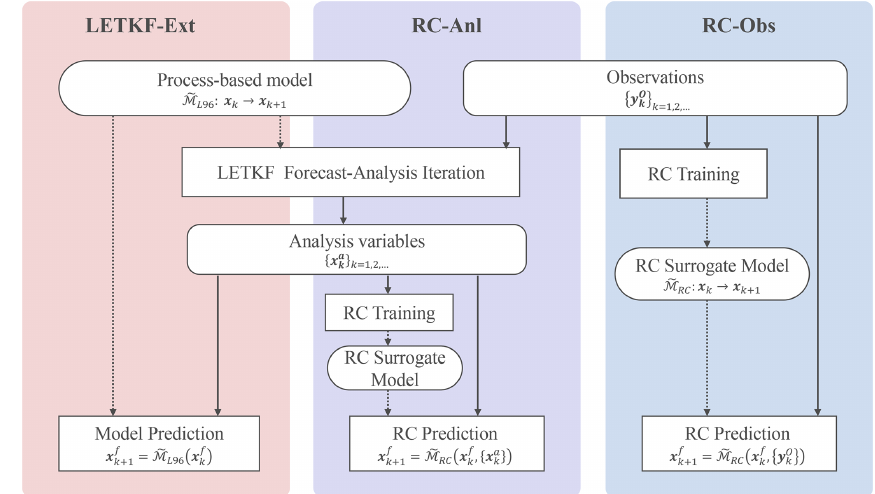
Figure 3. The algorithm flow of LETKF-Ext, RC-Anl, and RC-Obs. Solid and dotted lines show the flow of variables and models (either process-based or data-driven surrogate),